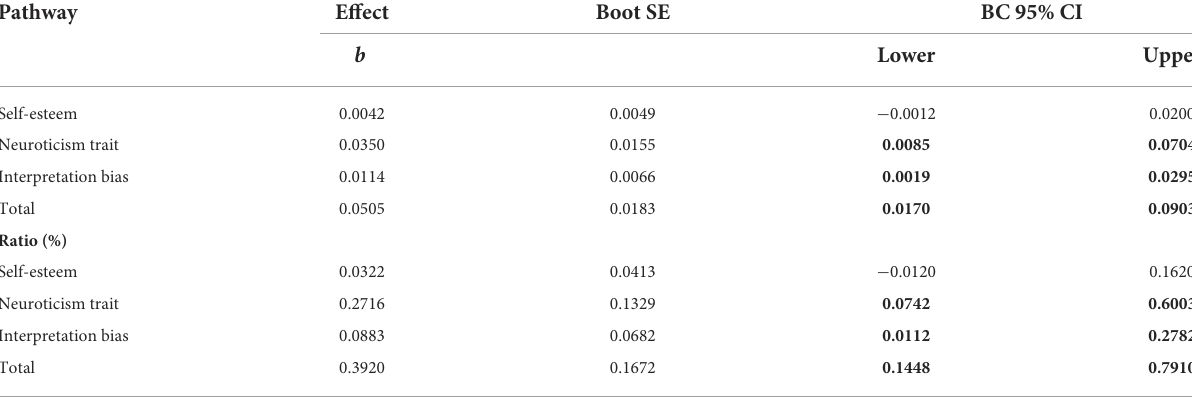
TABLE 4 Indirect effect of school bullying intensity (duration) on psychotic